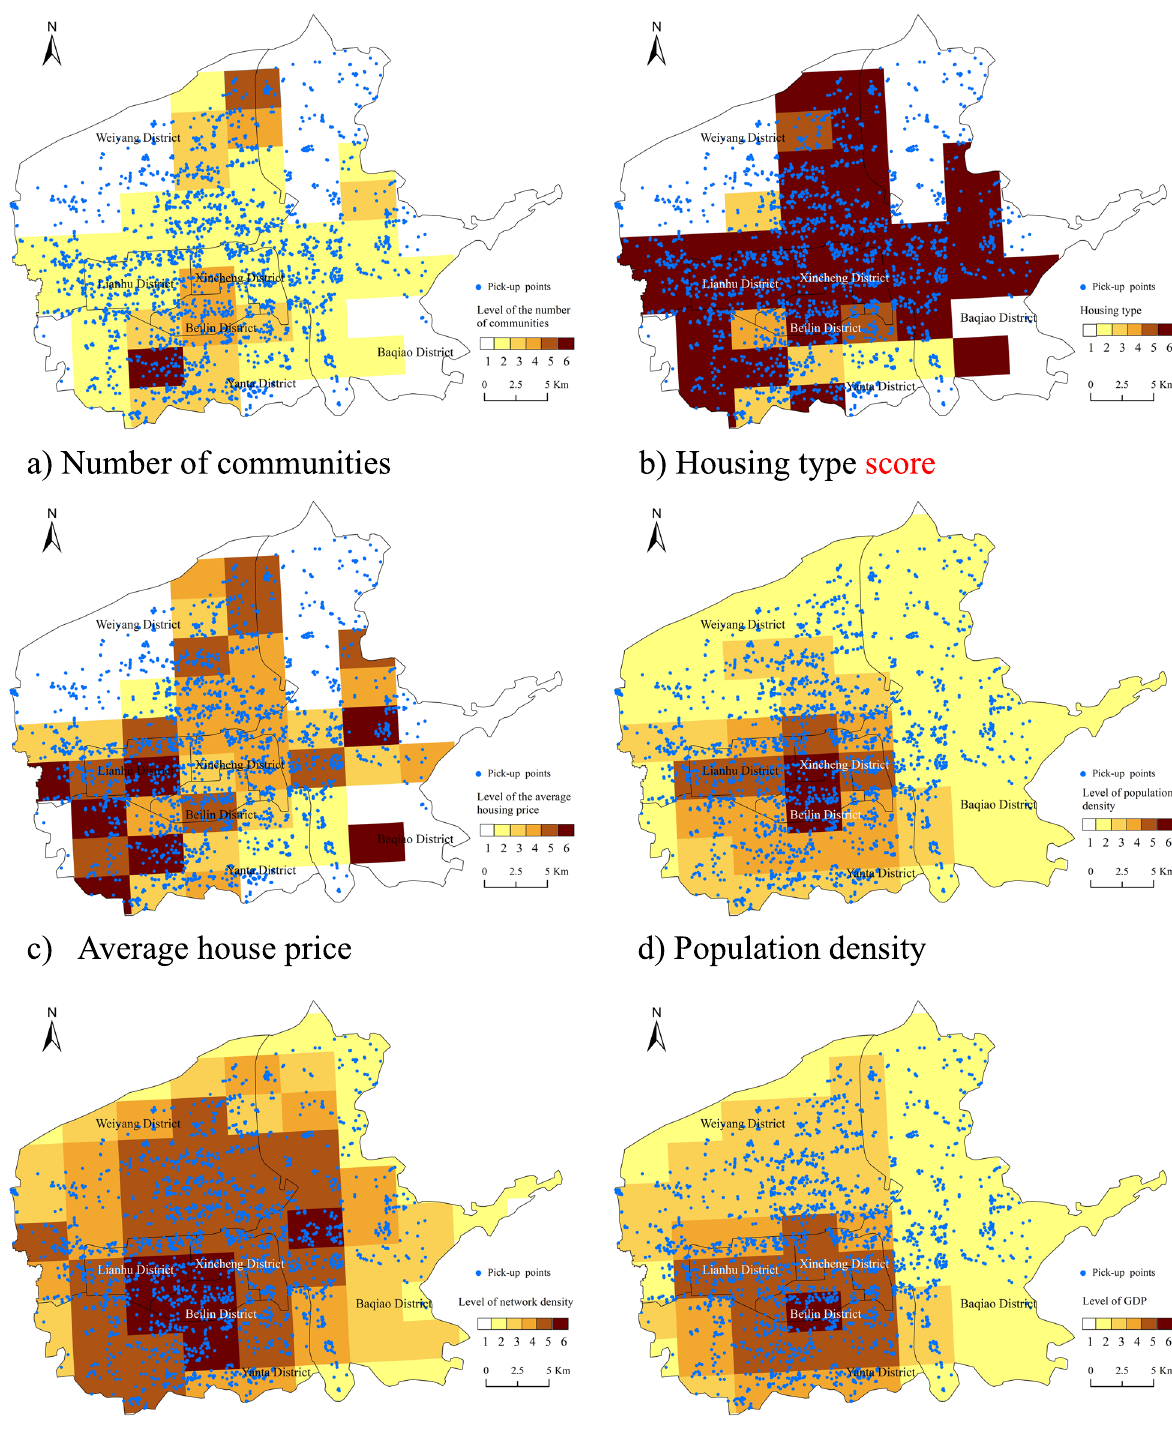
Fig. 5 Spatial distribution map of 6 potential influencing